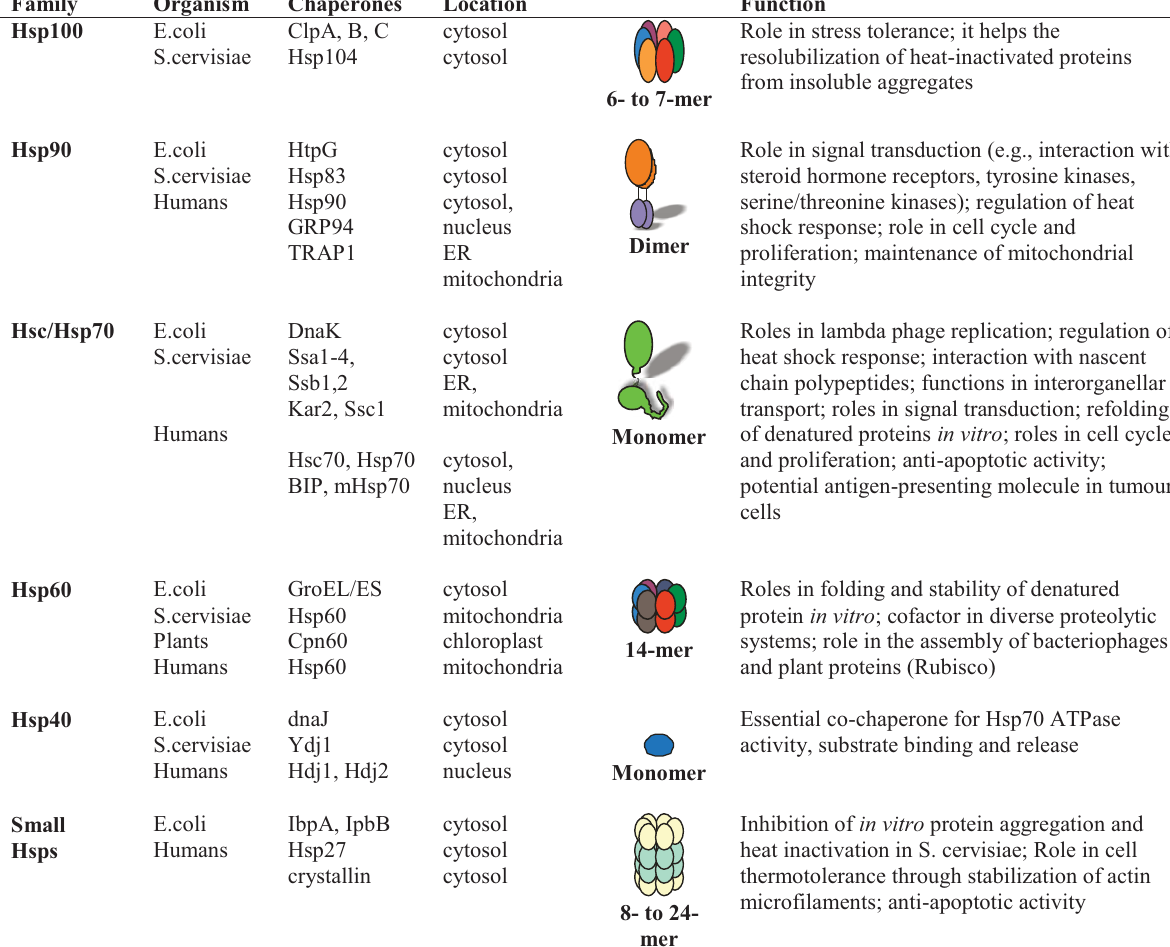
Table 1. Nomenclature, location and function of the major heat shock protein families.